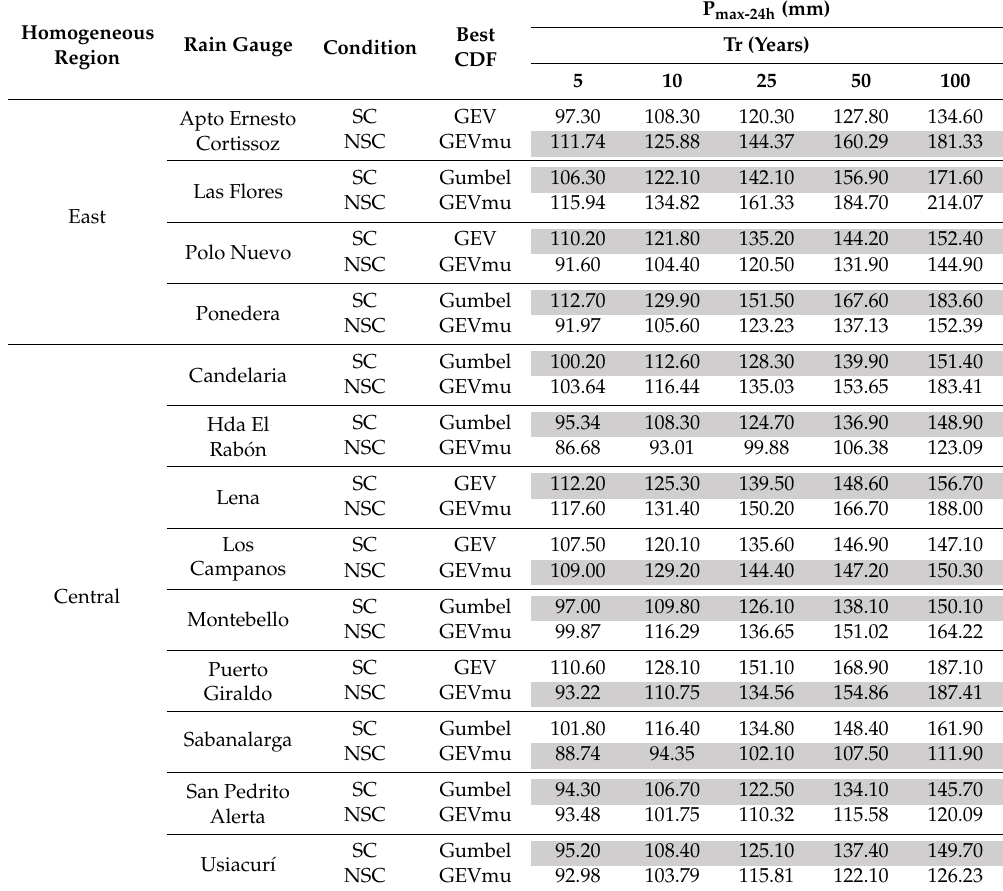
Table A1. P max-24h values under stationary and non-stationary conditions at each rain gauge. Homogeneous